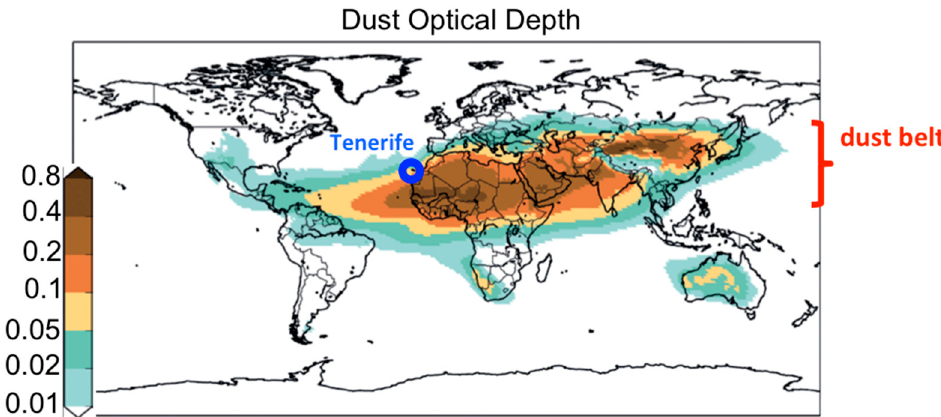
Figure 1. Global Dust Optical Depth highlighting the location of Tenerife and of the Dust Belt (WHO, 2017).